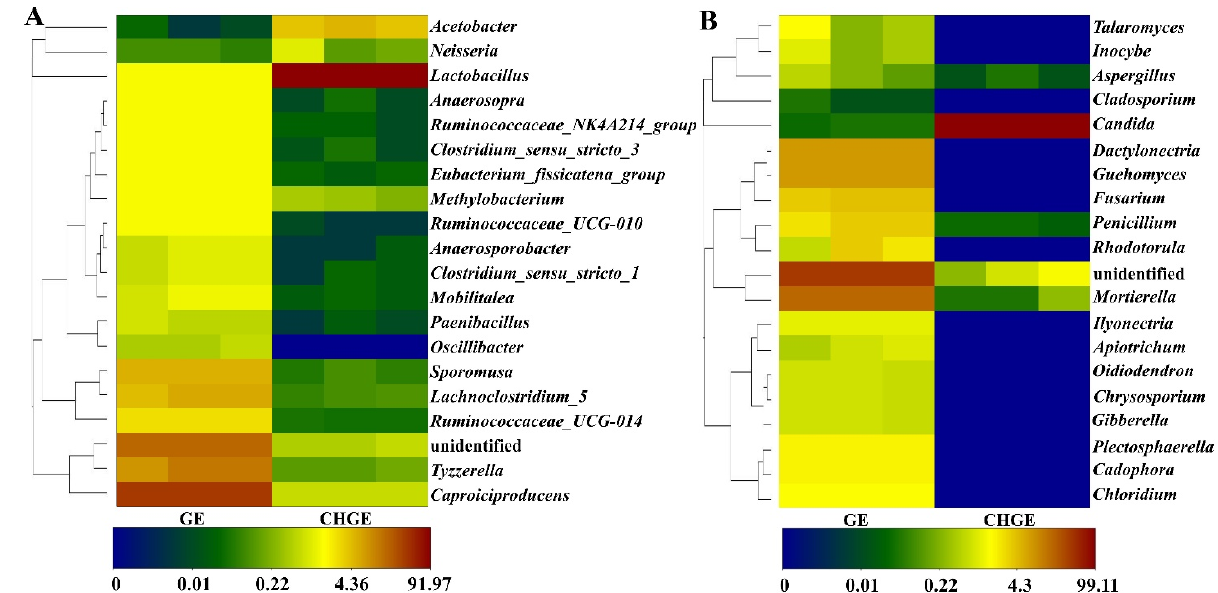
Figure 2. Heatmap clustering analysis of relative abundance of the top 20 communities for dominant bacterial genus ( A ) and fungal genus ( B ) in GE and CHGE.